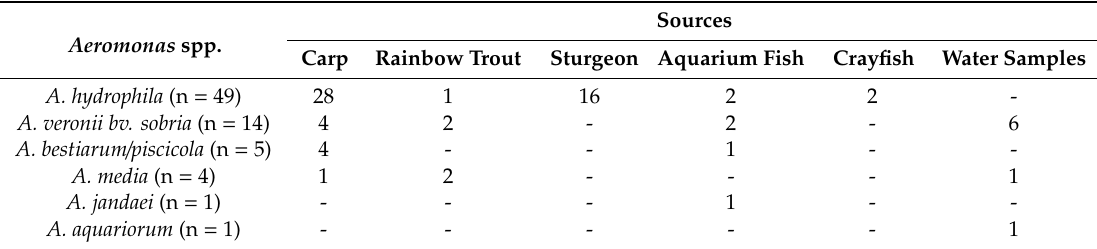
Table 2. The prevalence of Aeromonas spp. in di ff erent aquatic animals and water. Aeromonas